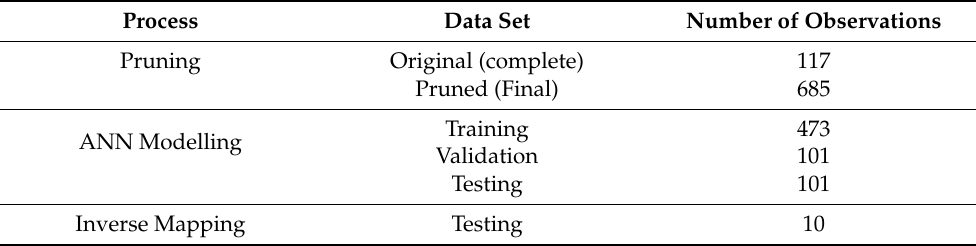
Table 1. Data segregation